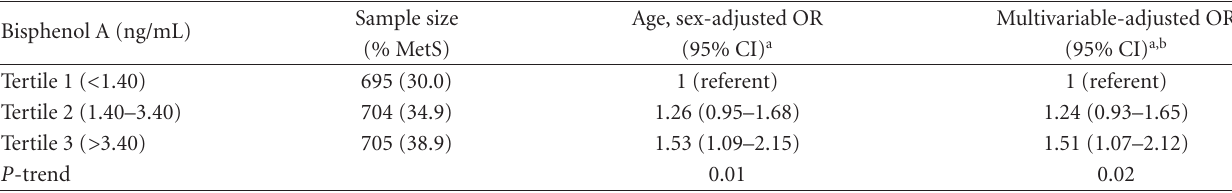
Table 2: Association between bisphenol A and metabolic